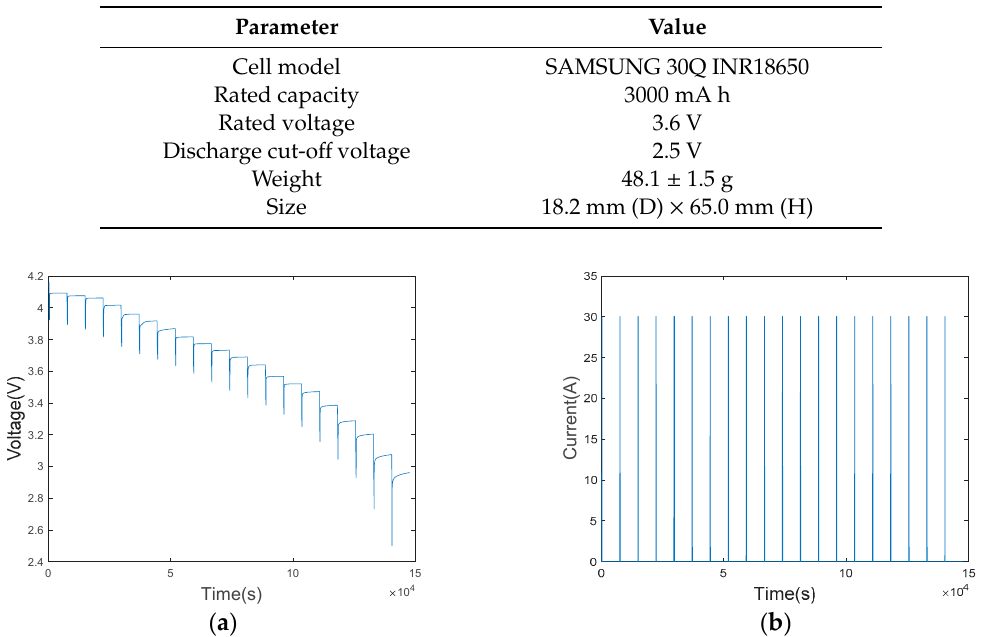
Table 1. Power lithium cell parameters.